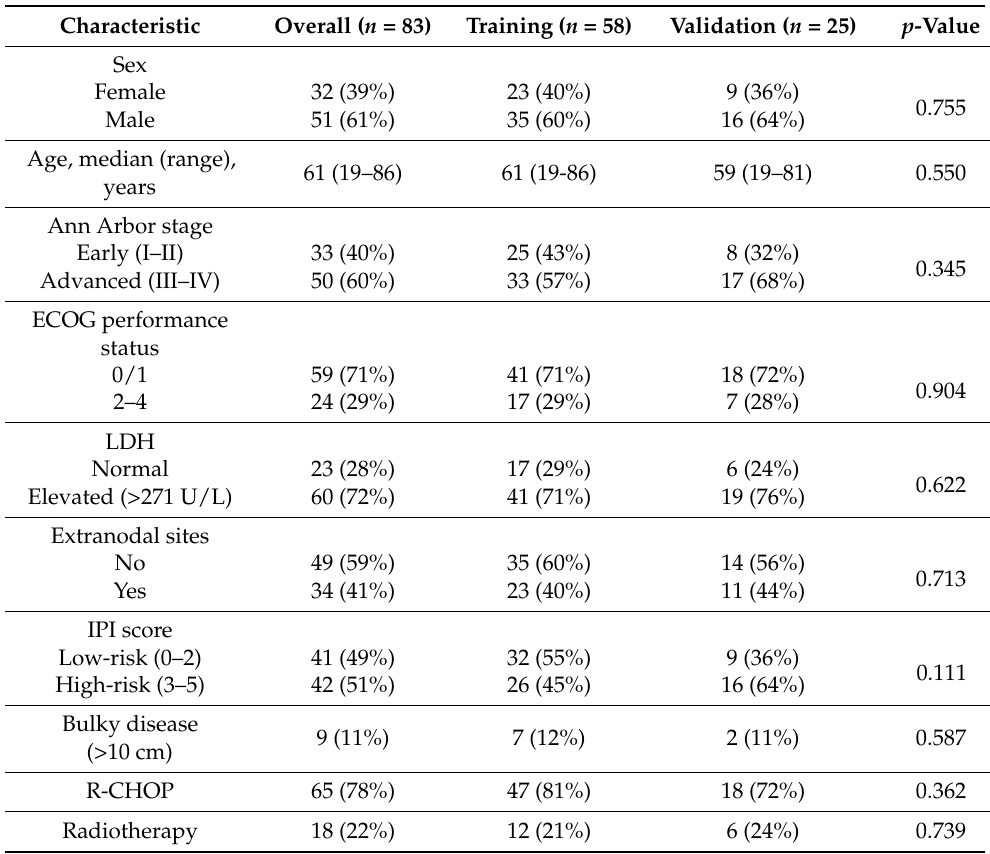
Table 1. Clinical Characteristics of Patients in the Training and Validation